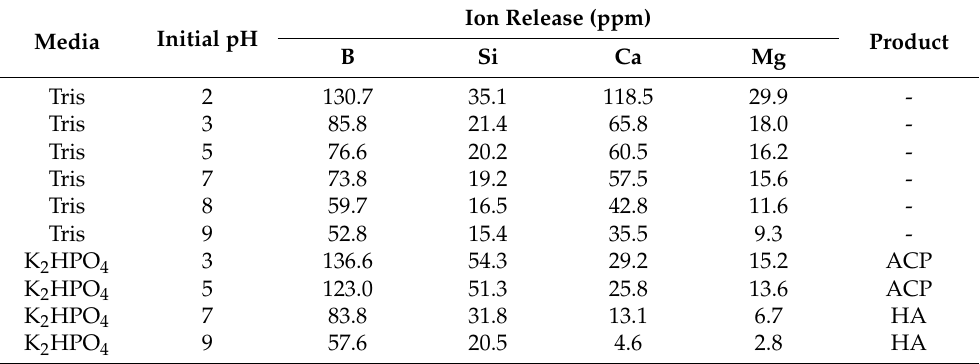
Table 1. Results of ion release in Tris (1 h) and K 2 HPO 4 (1 d) solutions with different initial pH and product in K 2 HPO 4 solutions (20 d) with different initial pH.